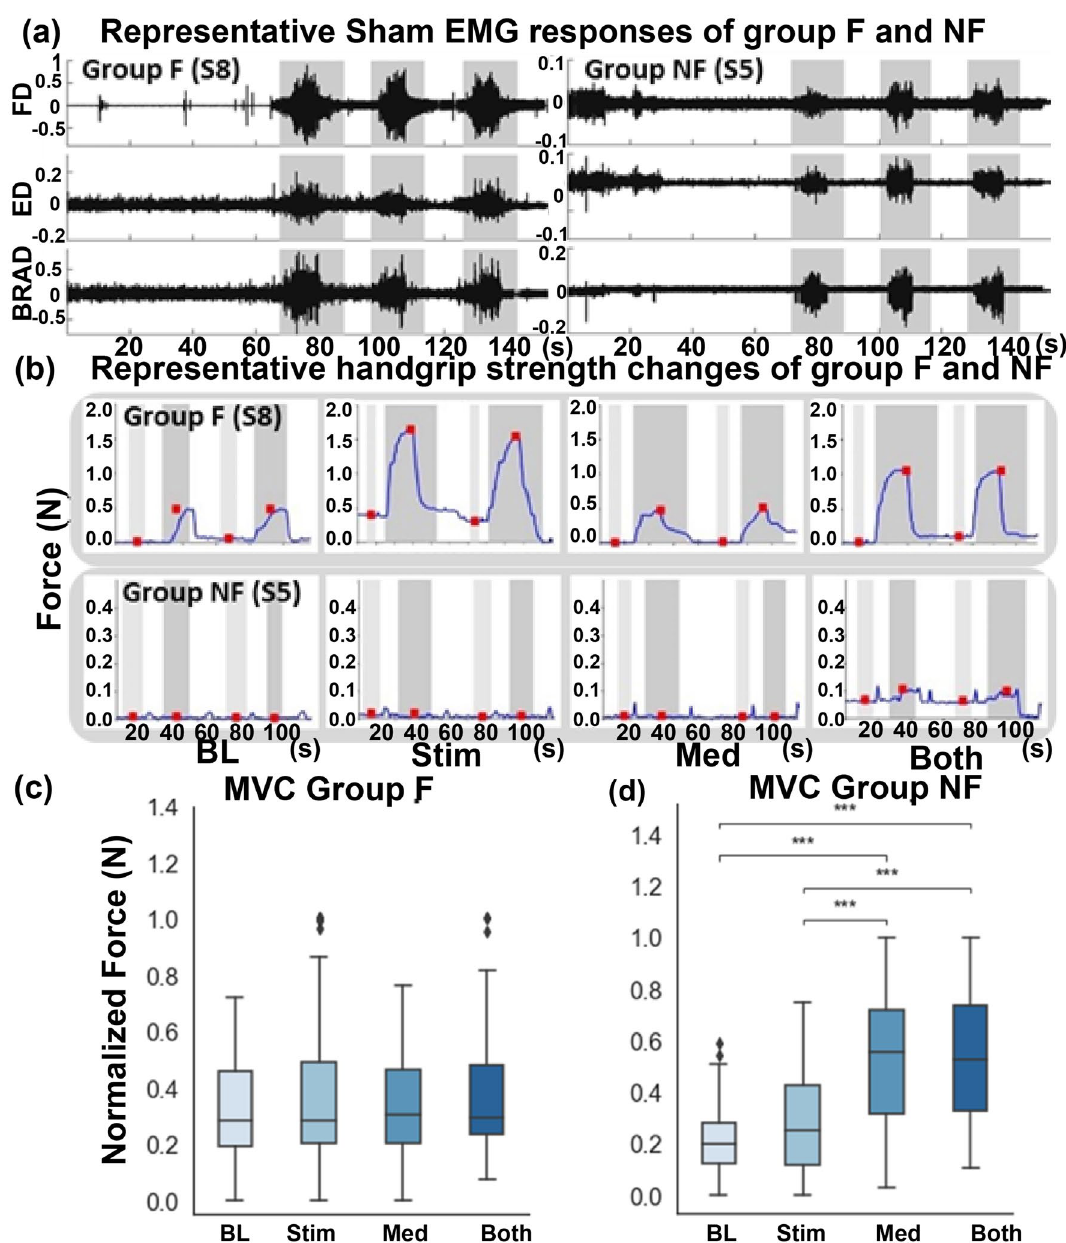
Figure 3. The performance of MVC test in Group F and NF. ( a ) Representative forelimb muscle EMG responses of one subject of each group (Group F: S8 and Group NF S5) during initial baseline testing. ( b ) Representative MVC results of the same subjects in the panel ( a ). Light gray bars indicate baseline measurement and dark gray bars indicate the time during the attempted pull. Red squares mark the baseline and the maximum values recorded (MVC: F, NF, n = 5 for each group). ( c , d ) Normalized MVC results from Group NF and Group F, respectively. The number of asterisks indicates the threshold significance level detected by three- way ANOVA; *: P < 0.05, **: P < 0.01, and ***: P < 0.001. Black diamonds indicate outlier values. Baseline (BL), stimulation only (Stim), medication only (Med) and combined stimulation and medication (Both). The means and the standard deviation (SD) are the usual P < 0.05 two-sided significance criterion. Data collected during the last three motor training sessions for each subject in each treatment phase 2–5 were analyzed. Shapiro–Wilk testing was performed to check the normality of the data distributions. For handgrip measurements, a three-way analysis of variance (ANOVA) with repeated measures was used with group (F/NF) as a between-subjects factor and phase and sessions as within-subject factors. For the functional tests, a two-way ANOVA with repeated measures was used with group and phase as within- and between-subject factors, respectively. We used Tukey’s test for pairwise comparisons